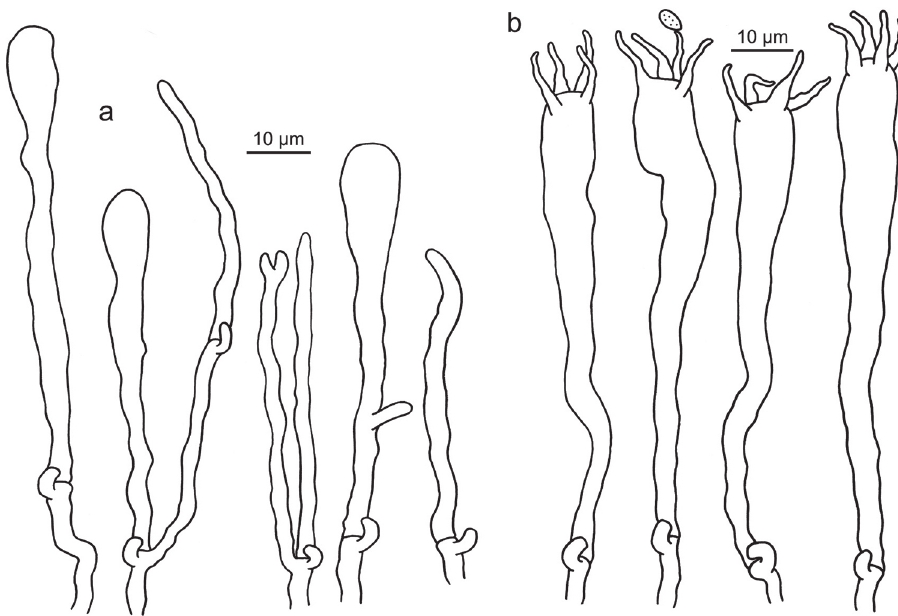
Figure 12. Microscopic features of Clavariadelphus ligula (HMAS 35954). a Leptocystidia and imma- ture basidia b